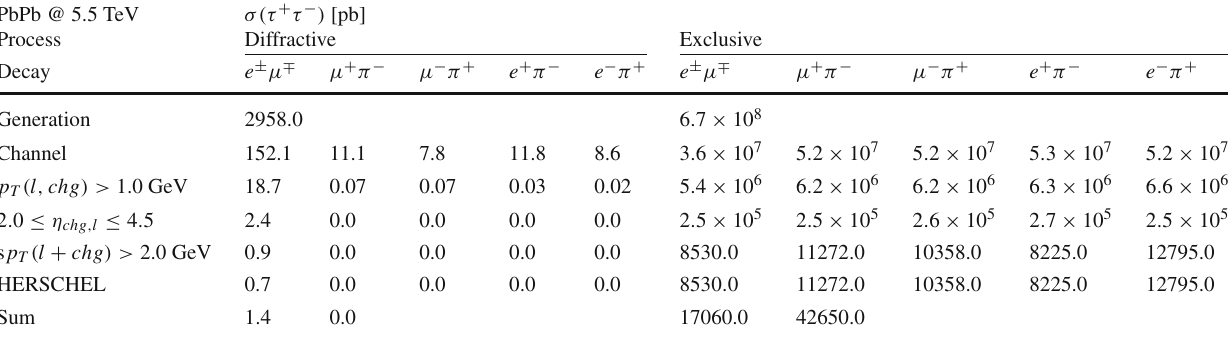
Table 3 Predictions for the ditau production at forward rapidities in PbPb collisions at considering the different decay channels PbPb @ 5.5